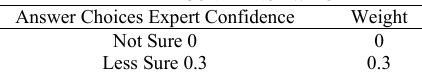
TABLE 1 E XPERT C ONFIDENCE W